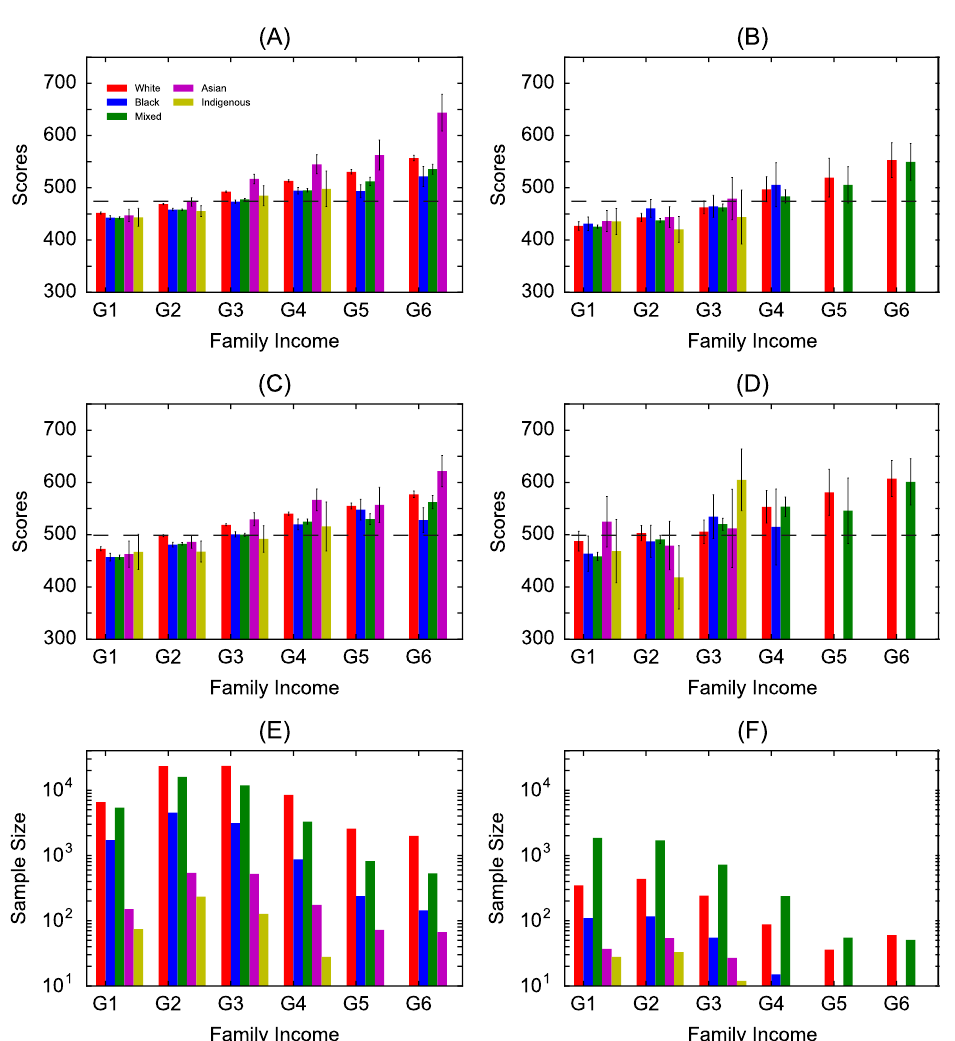
Figure 1. Mean performance score vs. household income level. The mean score for 5 ethnic groups and 6 income levels: ( A ) mathematics in Sao Paulo; ( B ) mathematics in Amazonas; ( C ) writing in Sao Paulo; and ( D ) writing in Amazonas. The sample size for the ethnic groups and income levels: ( E ) Sao Paulo and ( F ) Amazonas. The household income levels correspond to: G1: up to 1 minimum salary (411 USD in 2014); G2: between 1 and 2; G3: between 2 and 4; G4: between 4 and 6; G5: between 6 and 8; and G6: above 8. Black vertical bars represent the 95% confidence intervals and the horizontal dashed lines are the national mean for each